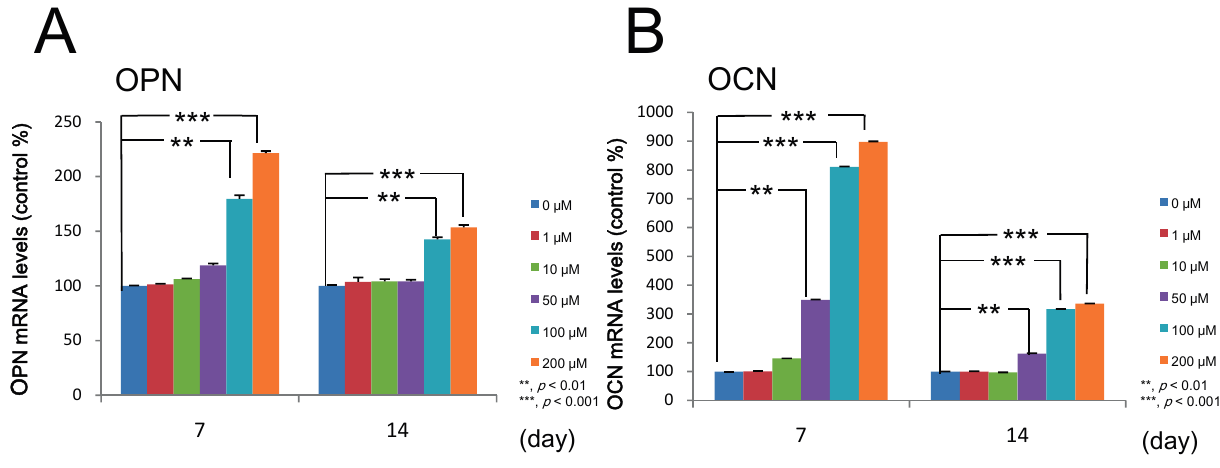
Figure 5. Effect of melatonin on the differentiation of DP-805 cells. DP-805 cells were plated at a cell density of 1 × 10 5 cells/well and cultured until they reached confluence. Thereafter, the cells were treated with various concentrations (0, 1, 10, 50, 100 and 200 µM) of melatonin for 14 days. Melatonin promoted the expression of mRNA for osteopontin (OPN) ( A ); bone sialoprotein (BSP) ( C ); dentin matrix protein-1 (DMP-1) ( D ) and dentin sialophosphoprotin (DSPP) ( E ) at concentrations equal to and more than 100 µM; The expression of mRNA for osteocalcin (OCN) ( B ) was also enhanced at concentrations of at least 50 µM. Values are expressed as the mean ± SEM. * p < 0.05, ** p < 0.01, *** p <